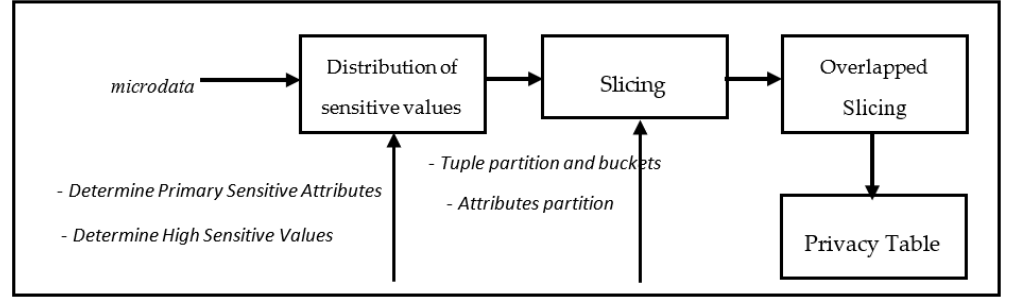
Figure 2. Framework of proposed model (Overlapped Slicing).